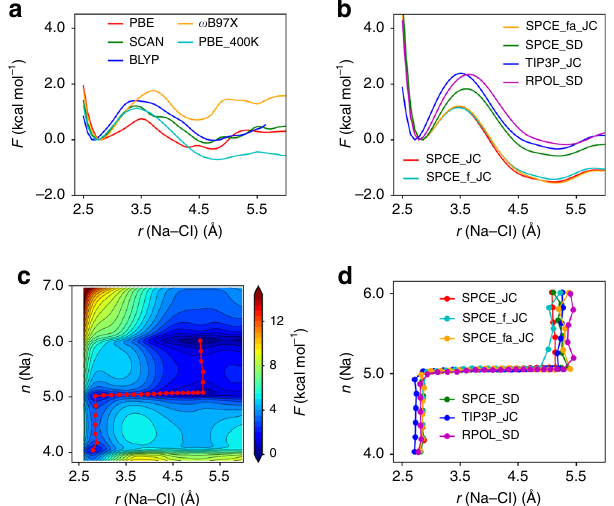
Fig. 2 Free energy surfaces (FESs) at ambient conditions. a 1D FESs as a function of Na – Cl distance r obtained from fi rst principles, using four different exchange-correlation energy functionals: PBE/SCAN/ ω B97X 23 , BLYP 24 at T = 300 K and the PBE functional at 400 K. b 1D FESs obtained with different empirical potentials. The fi rst principles results at 300 K are from refs. 23,24 all other results are from this work. c 2D FES as a function of r and n (Na – water coordination number) obtained with the SPCE_JC potential. The minimum free energy path (MFEP) is indicated by red dots. d MFEPs obtained with different empirical